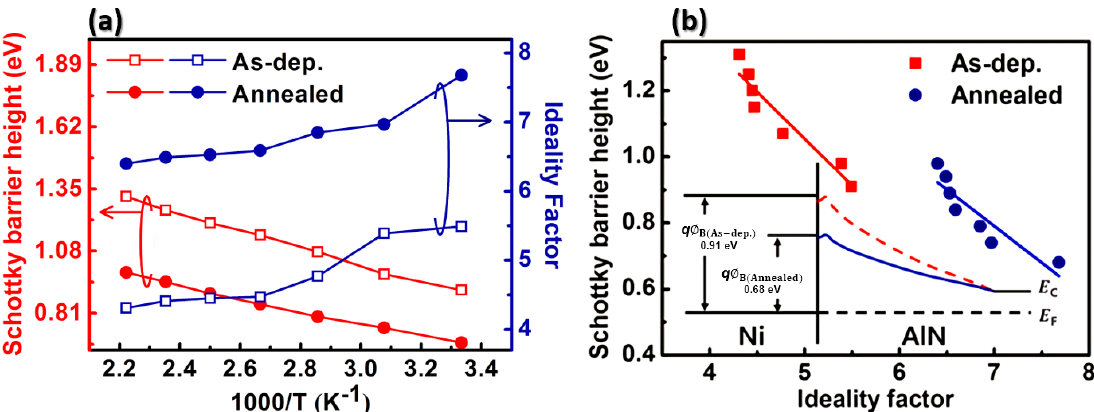
Figure 4. ( a ) Temperature dependence of the Schottky barrier height and ideality factor of each device. ( b ) the Schottky barrier height versus the ideality factor of each device. Inset: the energy band diagram of fabricated devices.